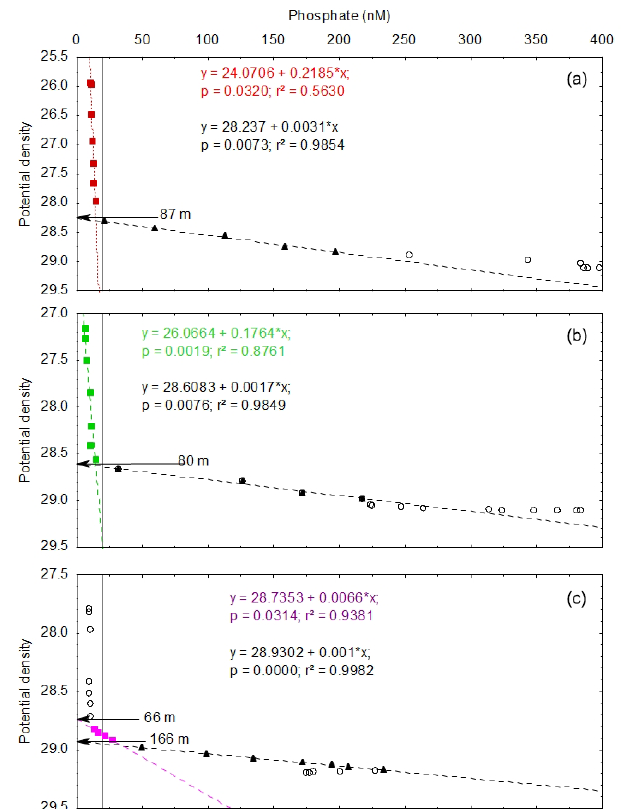
Figure 3. Diagrams of phosphate concentration versus density at FAST (a) , TYR (b) and ION (c) from the surface to the bottom and linear regressions between phosphate concentration and den- sity through the phosphacline (black symbols) and inside the PDL (colored symbols). Results of the regression analyses can be found in Table 2, and plots from short stations can be found in Fig. S1. Vertical gray lines mark the threshold between the nanomolar and micromolar phosphate dataset (phosphate concentration = 20nM).